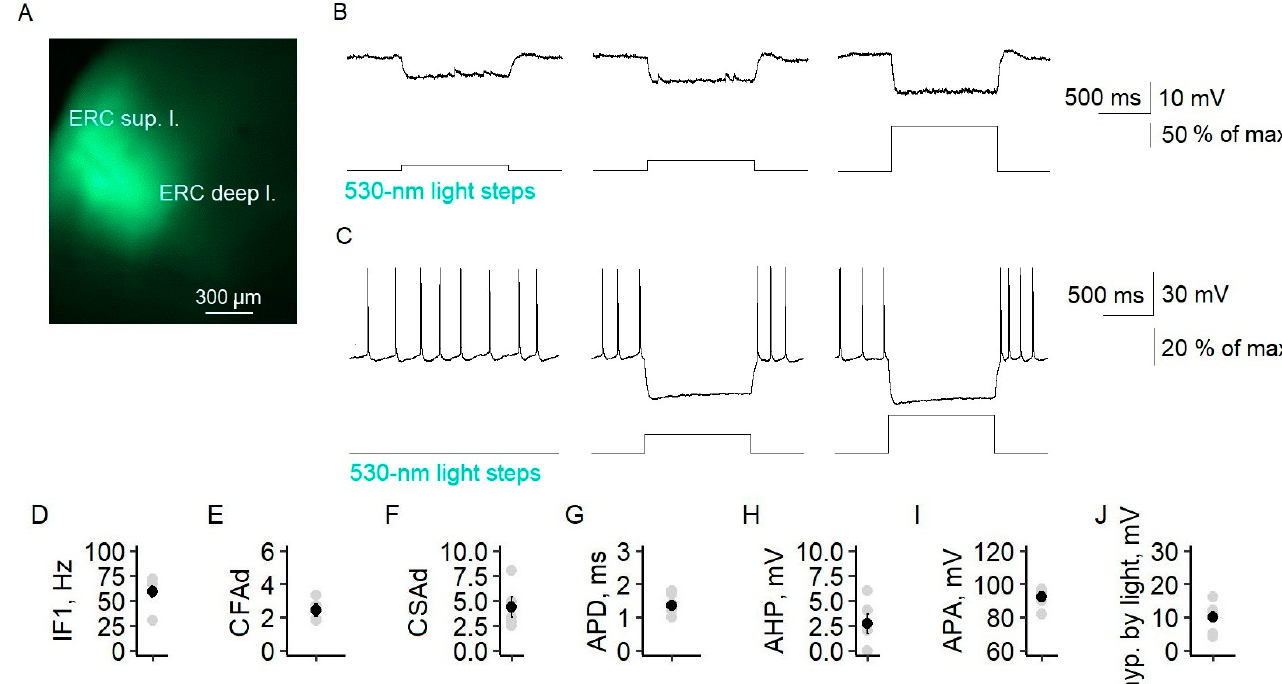
Figure 6. Specific expression of archaerhodopsin in CaMKII neurons. ( A ) Fluorescence micrograph of the entorhinal cortex (ERC) showing the efficiency of Arch-YFP expression. ( B ) A representative example of YFP neuron responses to light steps with different intensities. ( C ) Responses to light steps of a depolarized neuron. ( D – I ) The electrophysiological characteristics of YFP-positive neu- rons corresponded to regularly spiking pyramidal neurons: 1st instantaneous frequency (IF1 ( D )), coefficients of fast (CFAd ( E )) and slow adaptation (CSAd ( F )), action potential duration (APD ( G )), afterhyperpolarization (AHP ( H )), and action potential amplitude (APA ( I )). ( J ) Statistical data for the maximum hyperpolarization (hyp.) induced by light.